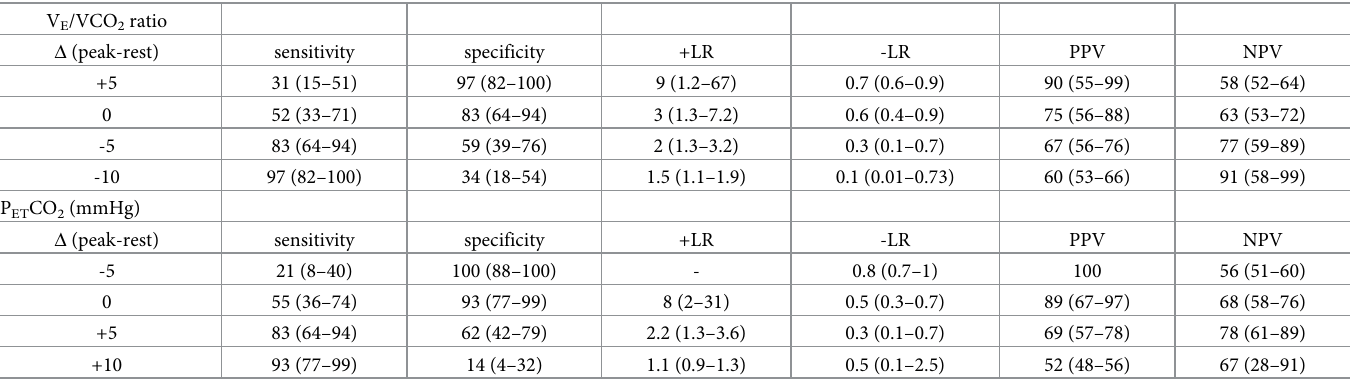
Table 4. Decision statistics for the change of V E /VCO 2 and P ET CO 2 cut-off values and